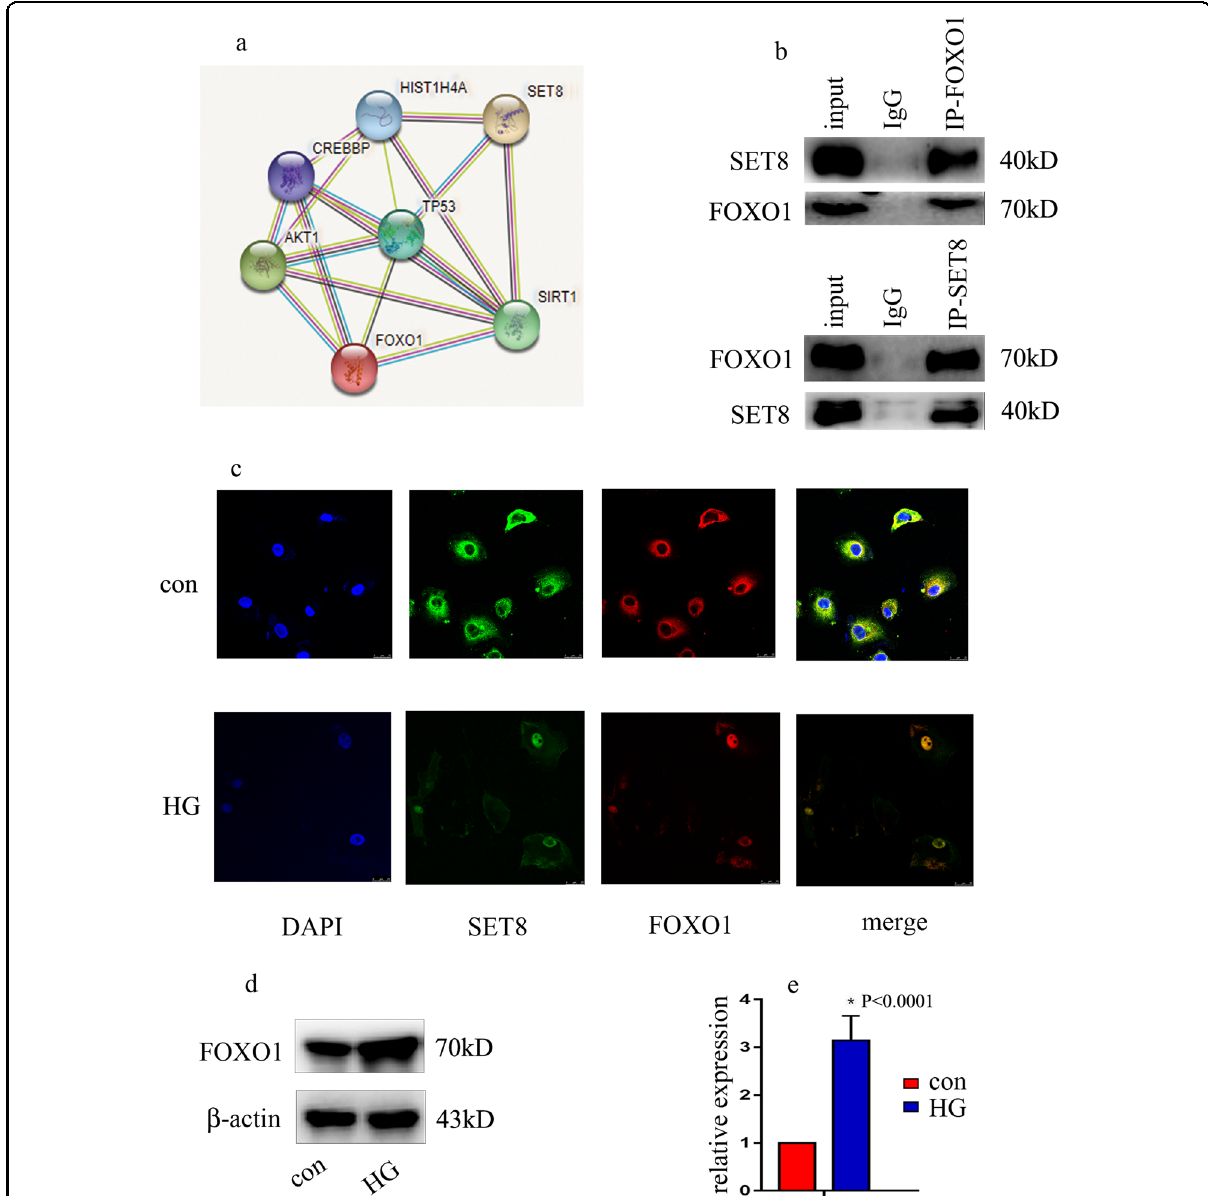
of the western blot analysis of FOXO1 in HUVECs cultured under normal or high-glucose conditions. e Results from the qPCR analysis of FOXO1 in HUVECs cultured under normal or high-glucose conditions. * P < 0.05, compared with the control group, n =